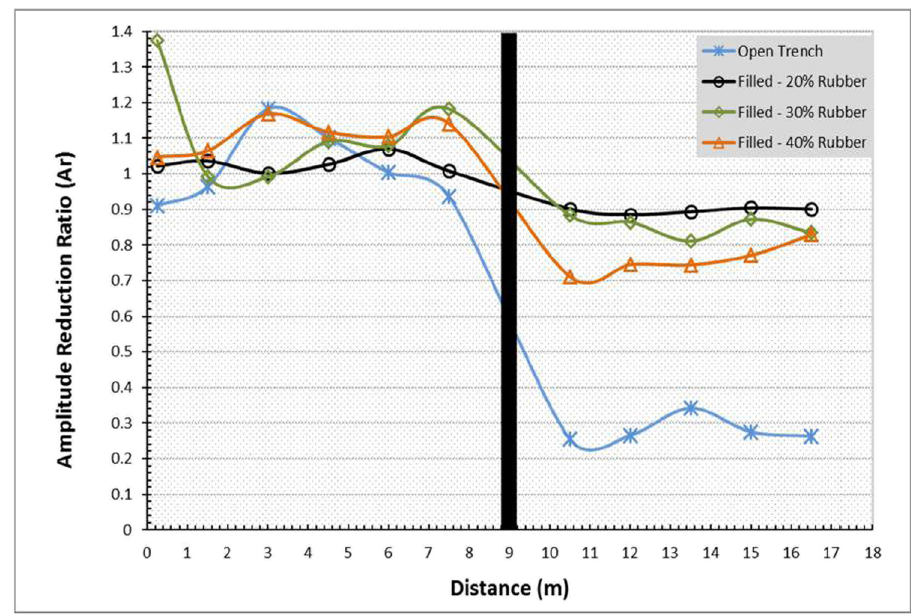
Figure 19: Attenuation of vibration due to passive trench barriers ( f 40 Hz = ) .